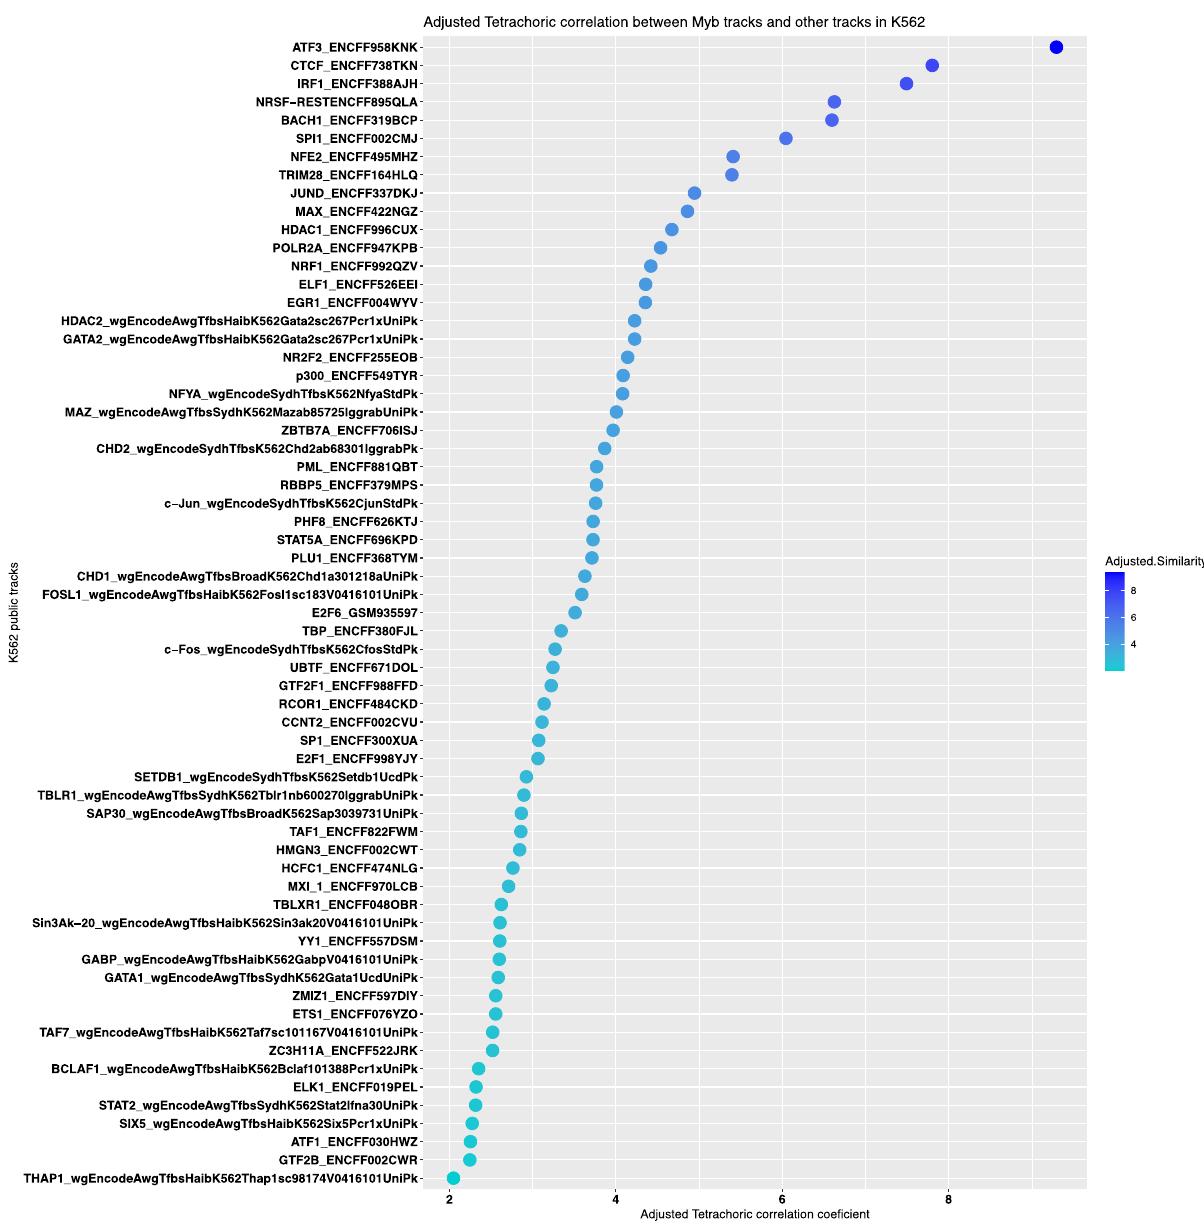
clade as an “enhancer cluster” and the red clade as a “promoter cluster”, the latter because it contains several fac- tors associated with TSS regions (POLR2A, TBP, TAF7, GTF2B, GTF2F1, and CHD1). The MYB ChIP-seq peaks clustered with the “enhancer cluster”. In contrast to the C-clusters above, this clustering is based on colocaliza- tion with other TFs, not allowing peaks to belong to multiple clusters. This puts MYB in a cluster enriched for enhancer regions, in line with the C2 group above. It is also consistent with the motif analysis where the second ranked enriched motif in the C2 group was for GATA-family factors. The ETS-family factors (ELK1, ETS1 and ELF1) with motifs enriched in the C1 group are found in the red clade (“promoter cluster”). A slightly different approach to address the colocalization issue is shown in Fig. 6. Here, we collected a set of publicly available ChIP-seq datasets for 63 targets (TFs, co-factors and proteins of genomic relevance) in addition to our current MYB ChIP-seq data, and carried out genomic colocalization analysis using the GSuite HyperBrowser 51 , a web tool that allows the interrogation of TF cooperativity at the genomic co-occupancy of